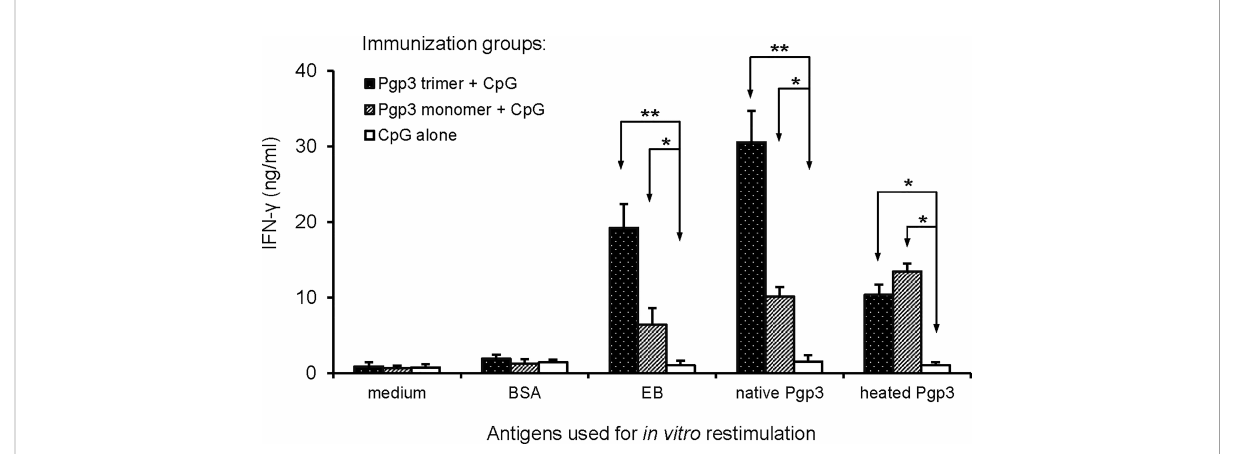
FIGURE 4 Induction of antigen-speci fi c IFN- g production following vaccination. Twenty days after the last immunization, splenocytes harvested from each group (5 mice/group) were restimulated in vitro with the following antigens as listed along the X-axis : medium alone, BSA at the concentration of 10ug/ml (1 m g per well), UV-inactivated C. muridarum EBs at 1 × 10 6 IFUs/well, native Pgp3 and heated Pgp3 at 10ug/ml. IFN- g production was evaluated 72 h after stimulation using an indirect ELISA. Results are expressed as ng/ml, as listed along the Y-axis (mean ± standard deviation). Results are representative of three independent experiments (* p < 0.05, ** p <